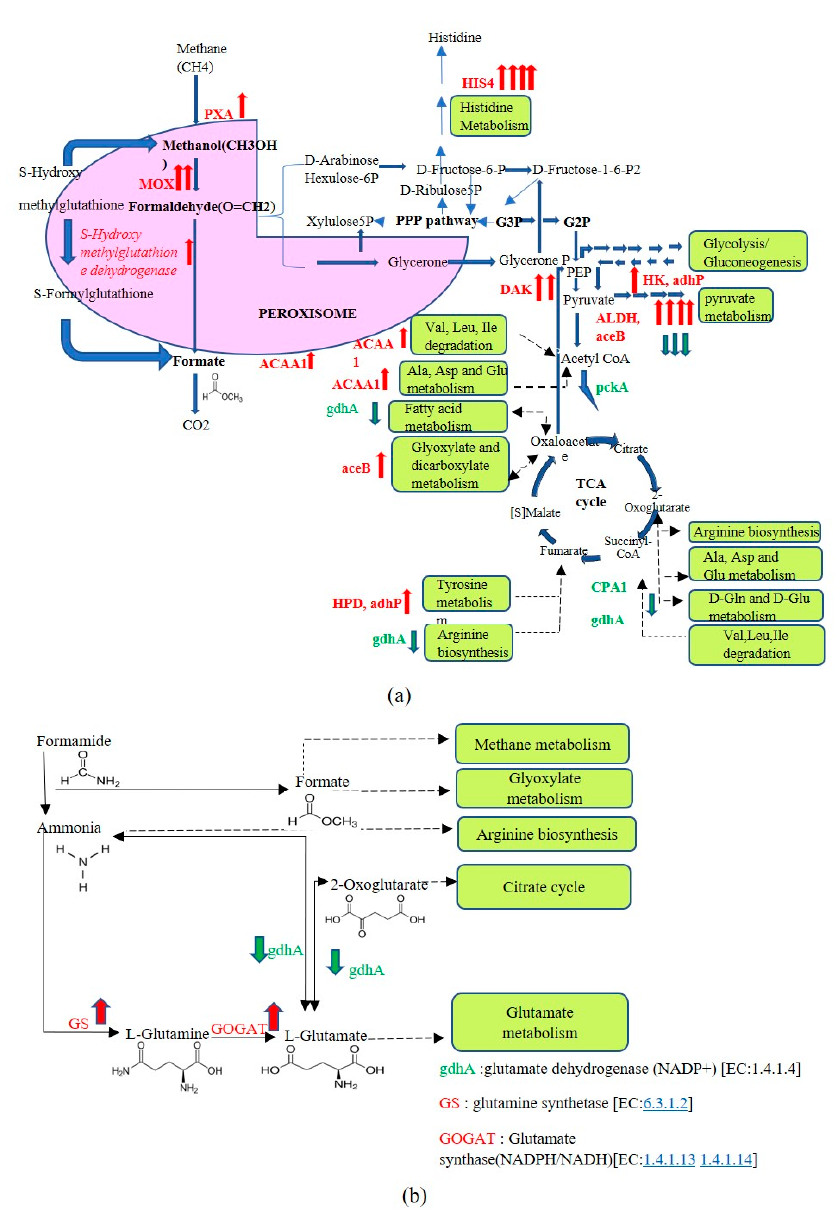
Figure 7. ( a ) Genes regulated in carbon metabolism under optimized conditions ( b ) Genes regulated in nitrogen metabolism according to KEGG pathways under optimized and unoptimized conditions. Intensity of up- (shown in red) and down-regulated (green) genes is shown by the number of arrows. One arrow represents log 2 fold unit change of 1.